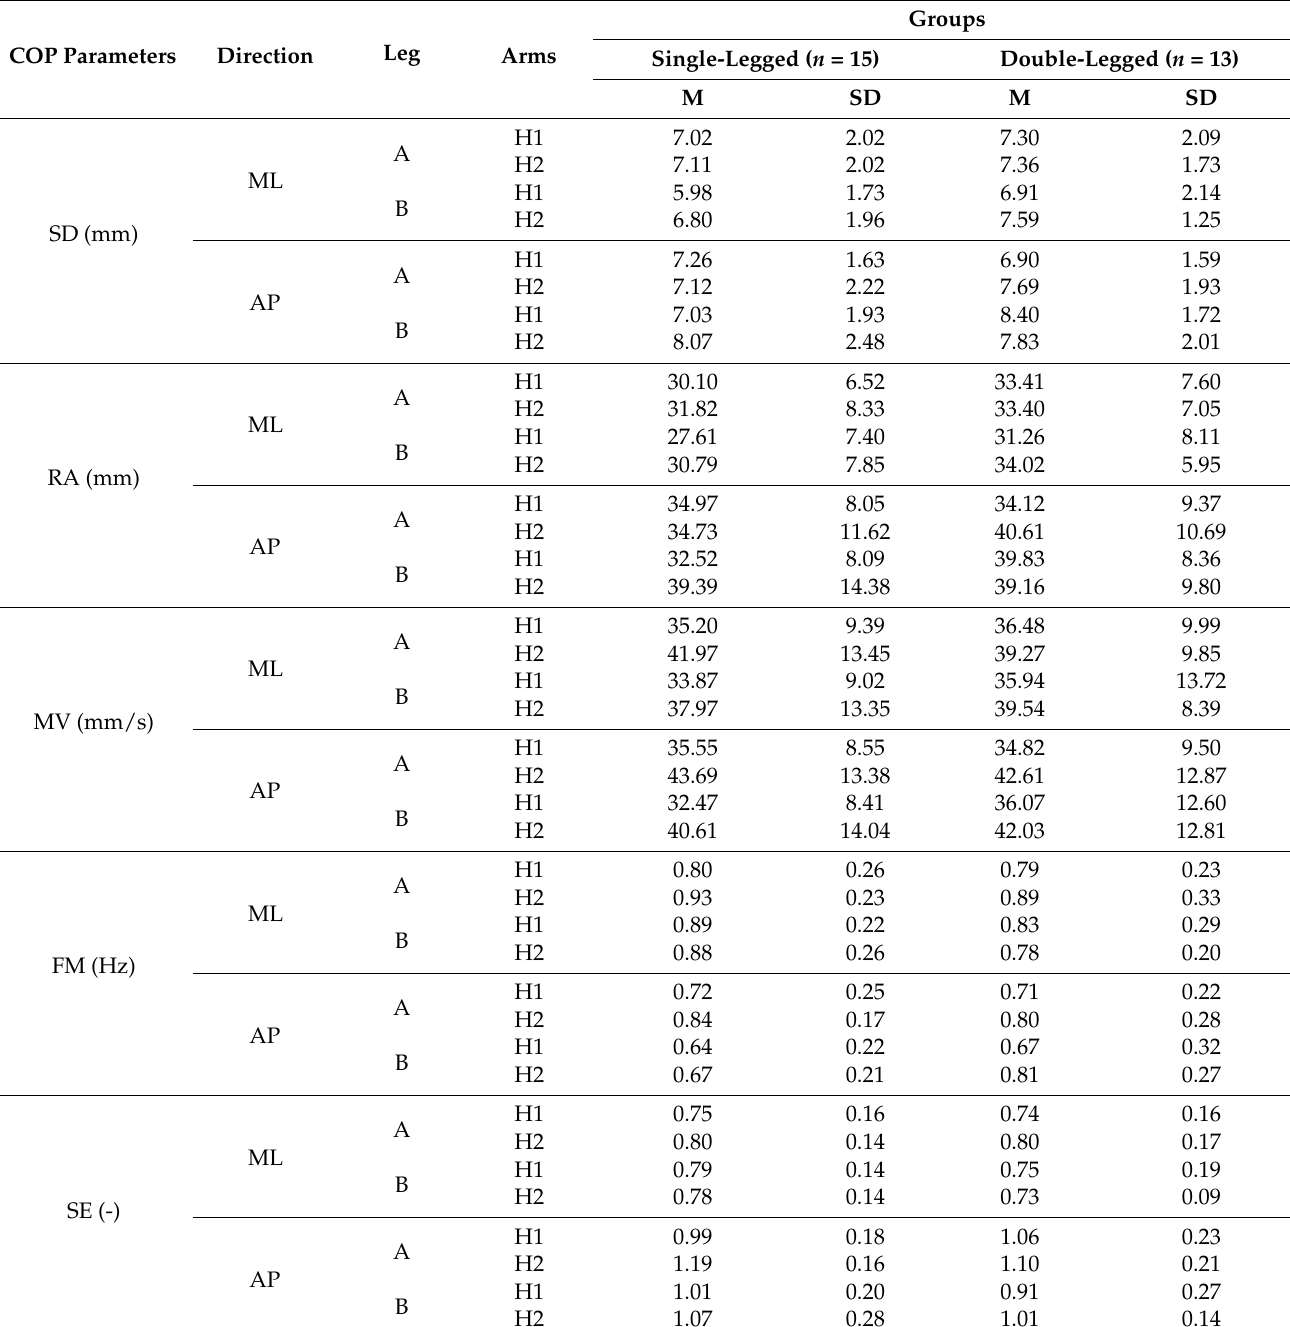
Table 2. Descriptive statistics for the total